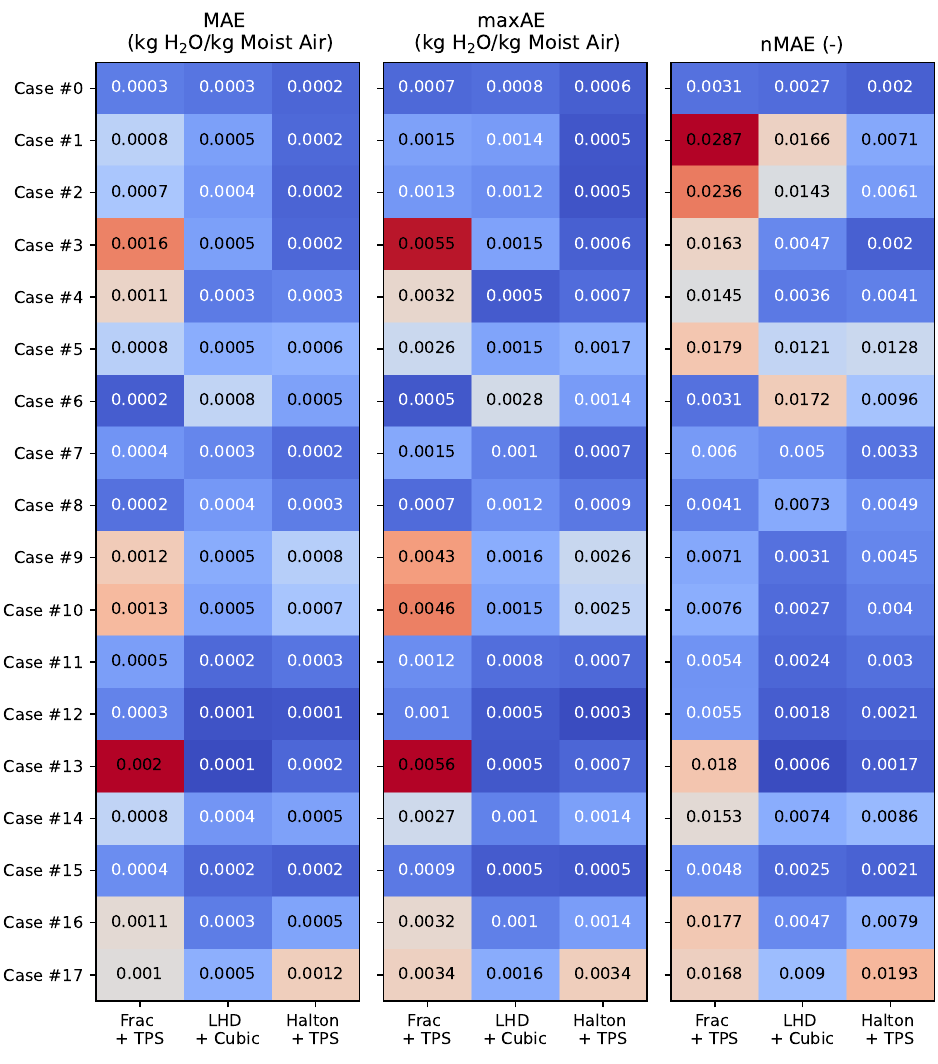
Figure 7. Evaluation of the error metrics for the prediction of the water mass fraction with the created surrogate models for the validation operating points